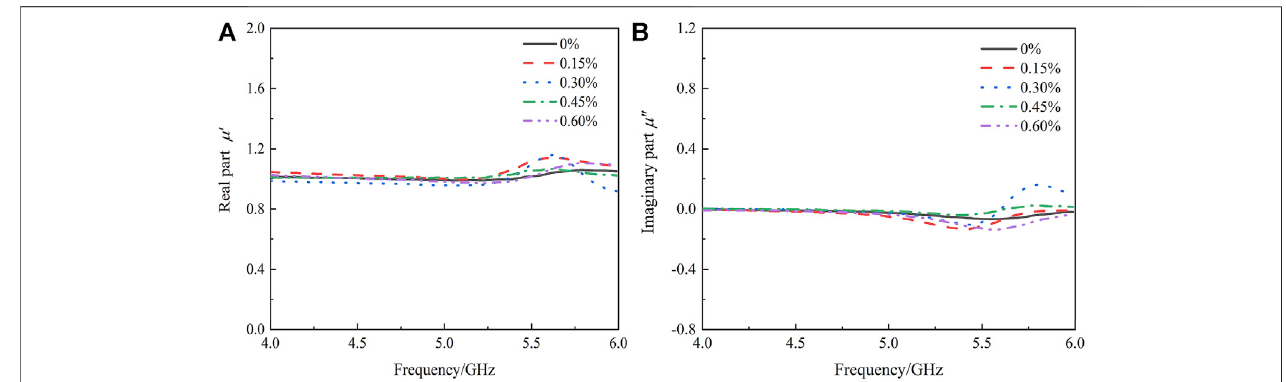
FIGURE 8 | The Permeability curve with frequency. (A) Real part of permeability (B) Imaginary part of permeability.